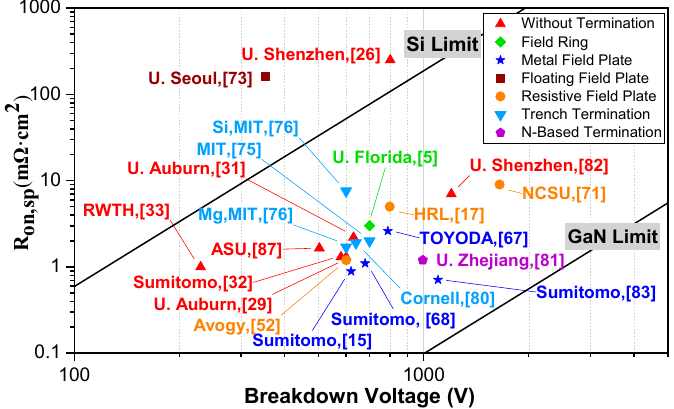
Figure 10. Benchmarks of the R ON,sp vs. BV of vertical SBDs with different edge termination techniques.